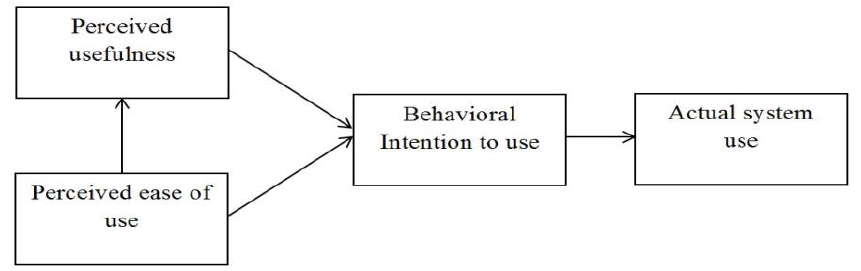
Figure 1: Technology Acceptance Model